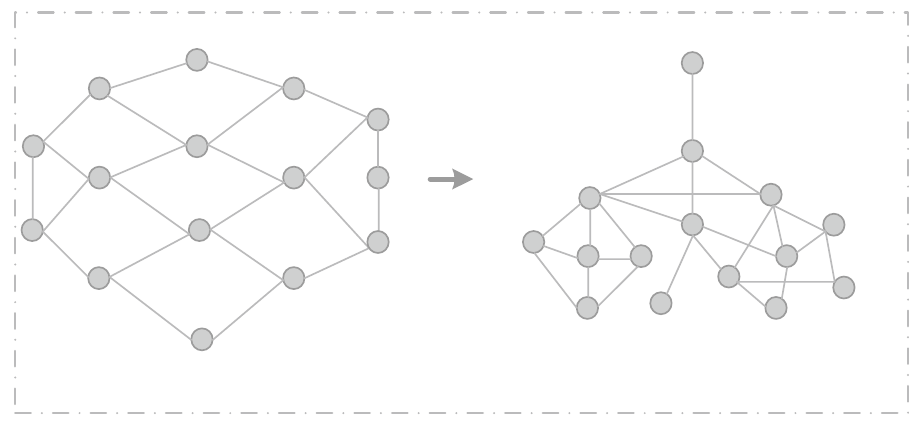
Fig. 2 Change in regional logis- tics network